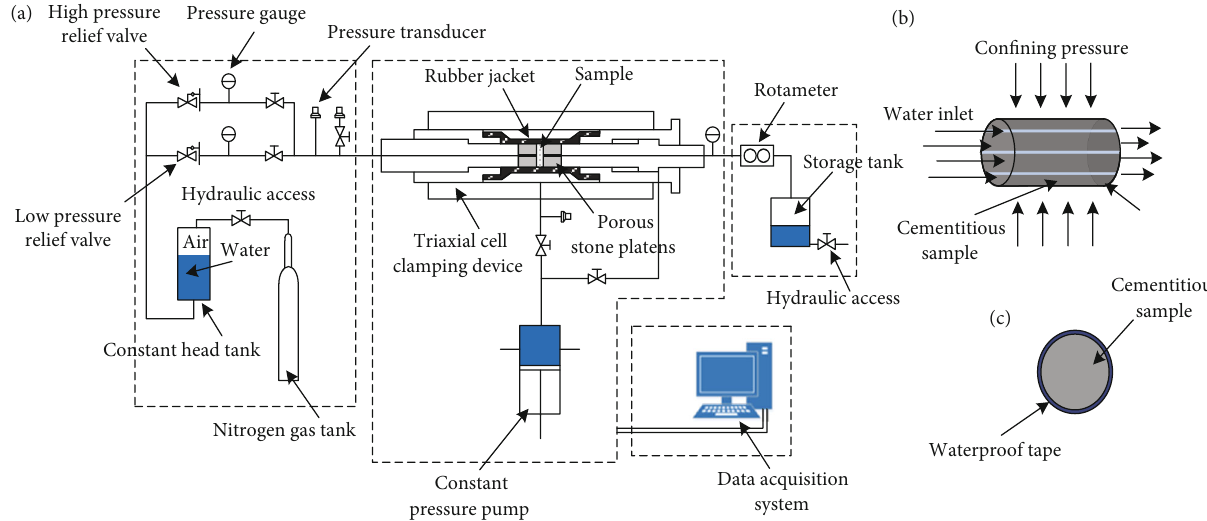
Figure 2: Schematic diagram of seepage testing system